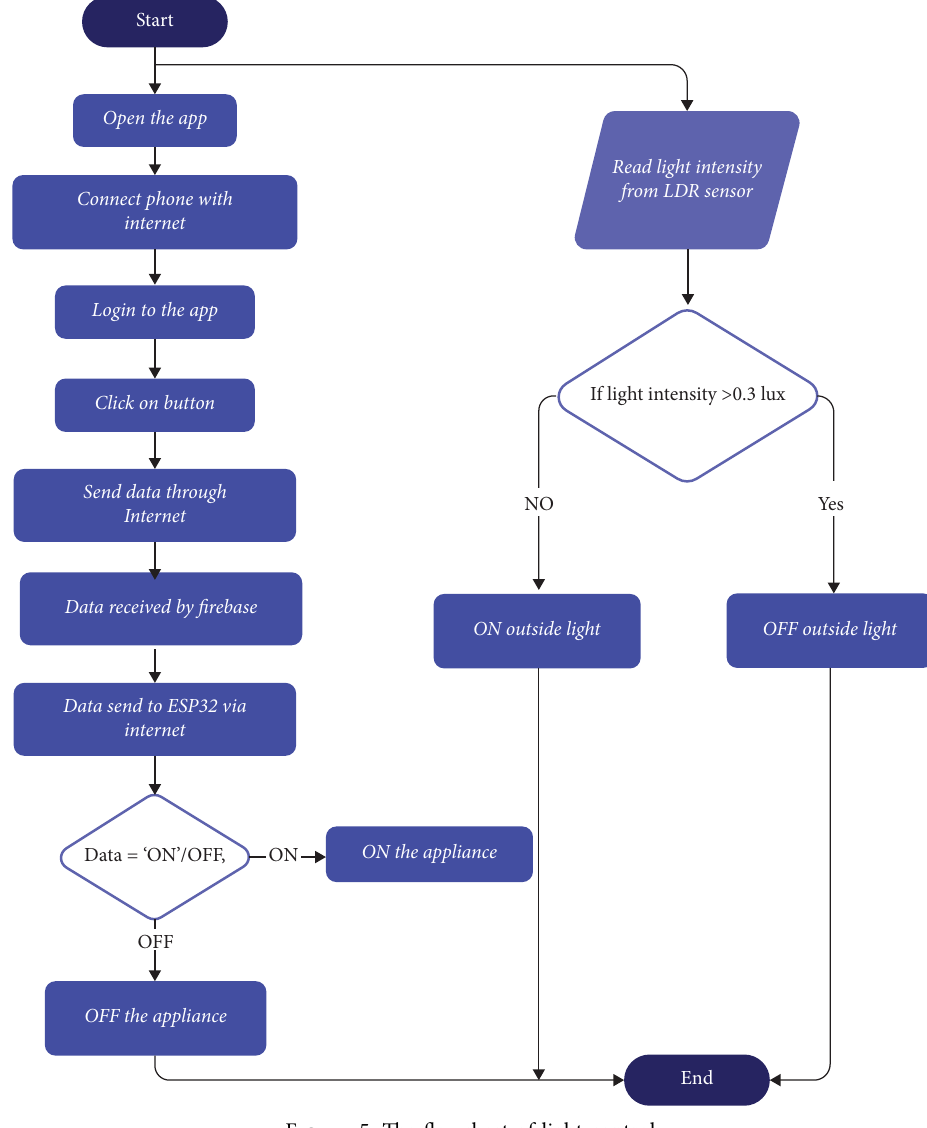
Figure 5: Te fowchart of light control.